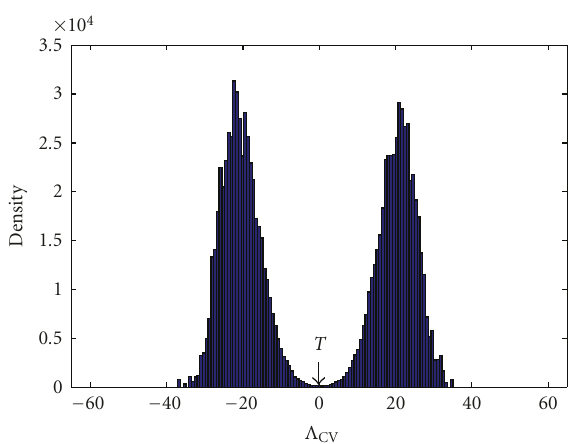
Figure 5: Simulated probability mass function (PMF) of Λ CV considering P ( H = 0) = P ( H = 1).